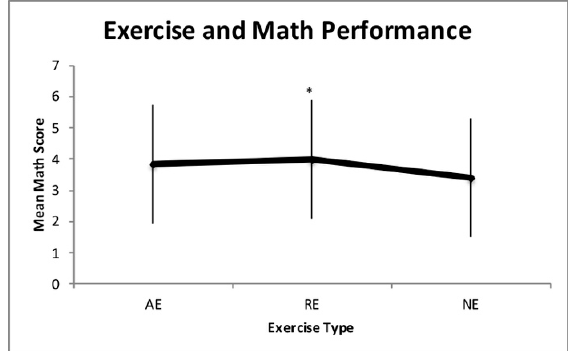
Figure 1. Mathematics performance following aerobic exercise (AE), resistance exercise (RE), and non-exercise (NE). * Denotes statistical significance ( p < 0.05).